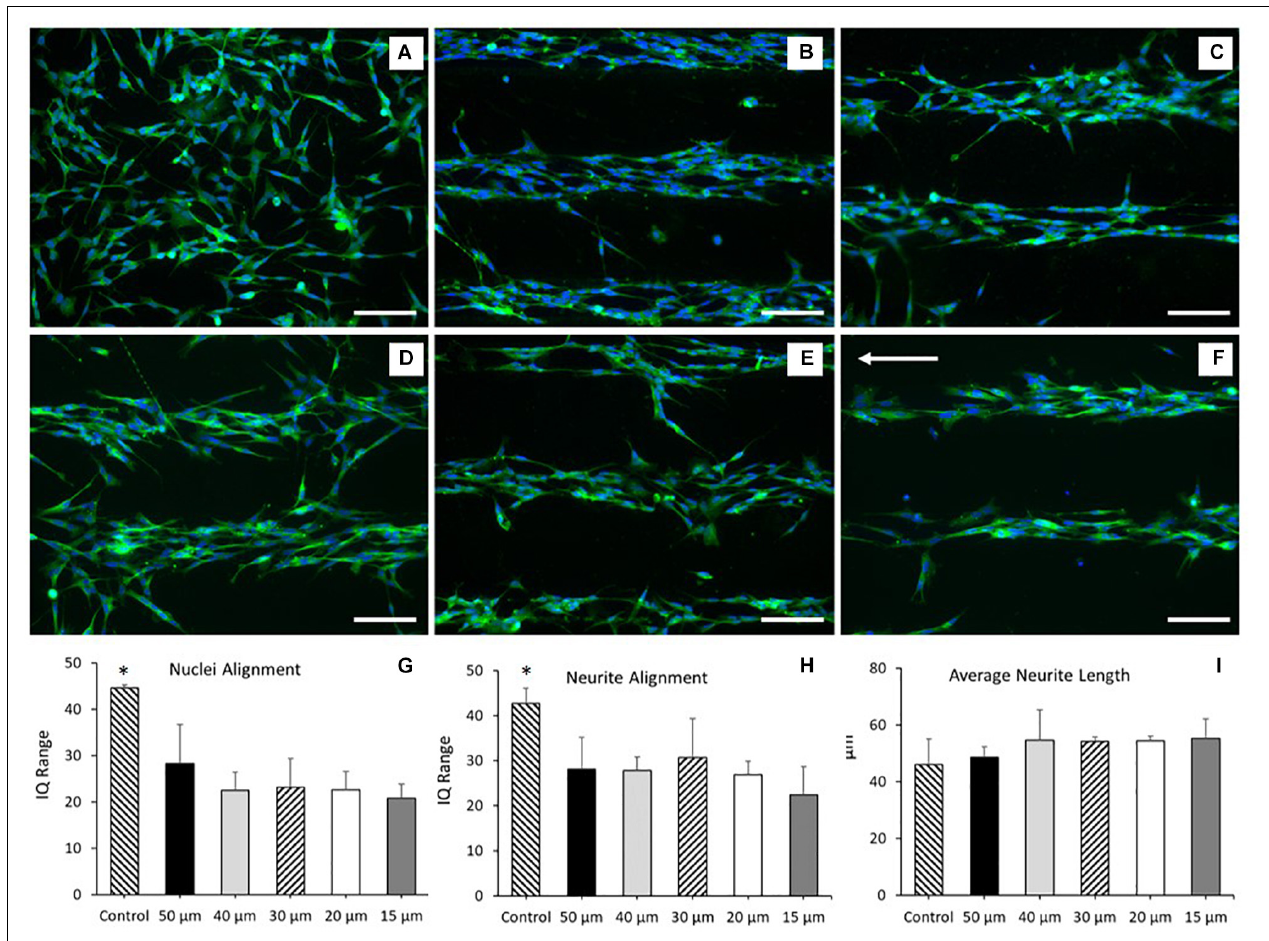
FIGURE 4 | Morphological staining of SH-SY5Y neuroblastoma cells cultured on patterned PEDOT:PSS glass substrates. Green = β -tubulin, blue = DAPI. Arrow indicates direction of PEDOT:PSS tracks deposited via aerosol jetting. (A) Untreated glass control. (B) 50 µ m tracks. (C) 40 µ m tracks. (D) 30 µ m tracks. (E) 20 µ m tracks. (F) 15 µ m tracks. Scale bar = 100 µ m. (G) Nuclei alignment of SH-SY5Y neuroblastoma cells after 72 h in DM, cultured directly onto a patterned PEDOT:PSS glass substrate. (H) Neurite alignment of SH-SY5Y neuroblastoma cells after 72 h in DM, cultured directly onto a patterned PEDOT:PSS glass substrate. (I) Average neurite length of SH-SY5Y neuroblastoma cells after 72 h in DM, cultured directly onto a patterned PEDOT:PSS glass substrate. Data presented as mean ± SD from n = 6 experimental repeats in each condition. ∗ significantly different from all other conditions ( P <